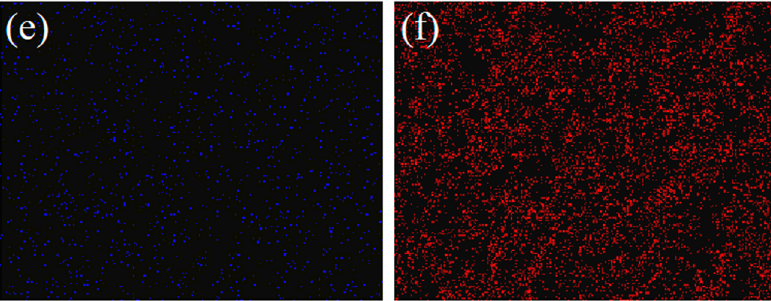
Figure 3. Energy dispersive spectrometry (EDS) patterns of the undoped LiNi 0.5 Mn 1.5 O 4 ( a ) and Er-doped LiNi 0.5 Mn 1.5 O 4 ( b ) sample (The inset in Figure 3a,b is corresponding EDS data); ( c – f ) Elemental mapping images of Ni, Mn, Er, and O elements in the Er-doped LiNi 0.5 Mn 1.5 O 4 sample.